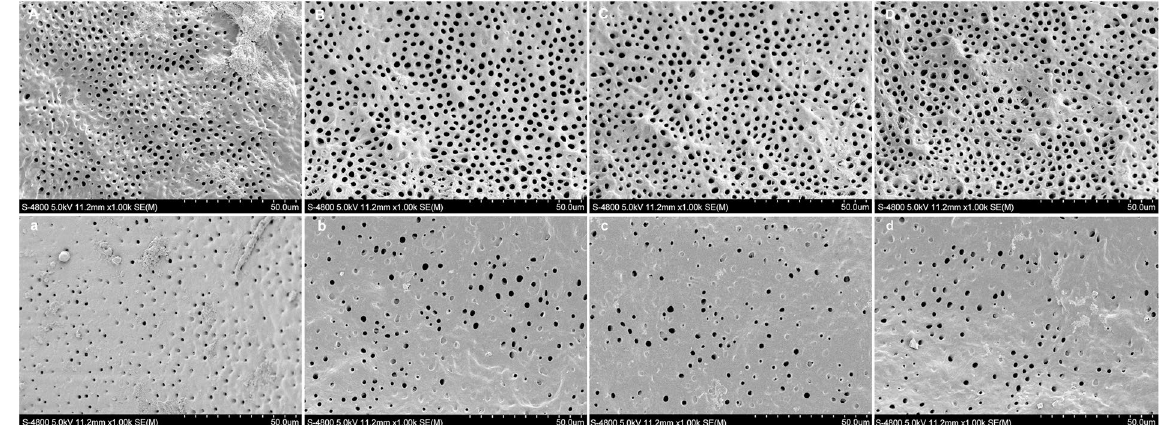
Figure 5. SEM photomicrographs of post space surfaces after treatments with different irrigants and phosphoric acid etching ( × 1,000). Only small part of smear layer remained on the post spaces of all groups. Compared with PA + BC groups ( A and a ), PA + NA groups ( B and b ) showed higher level of demineralization on dentin surfaces with wider opening of the dentinal tubule orifices. Less smear layer was covered in coronal regions ( A and B ) with wider opening of dentinal tubules than in apical region ( a and b ). PA + NEG groups ( C and c ) and PA + NE ( D and d ) groups showed similar to PA + NA